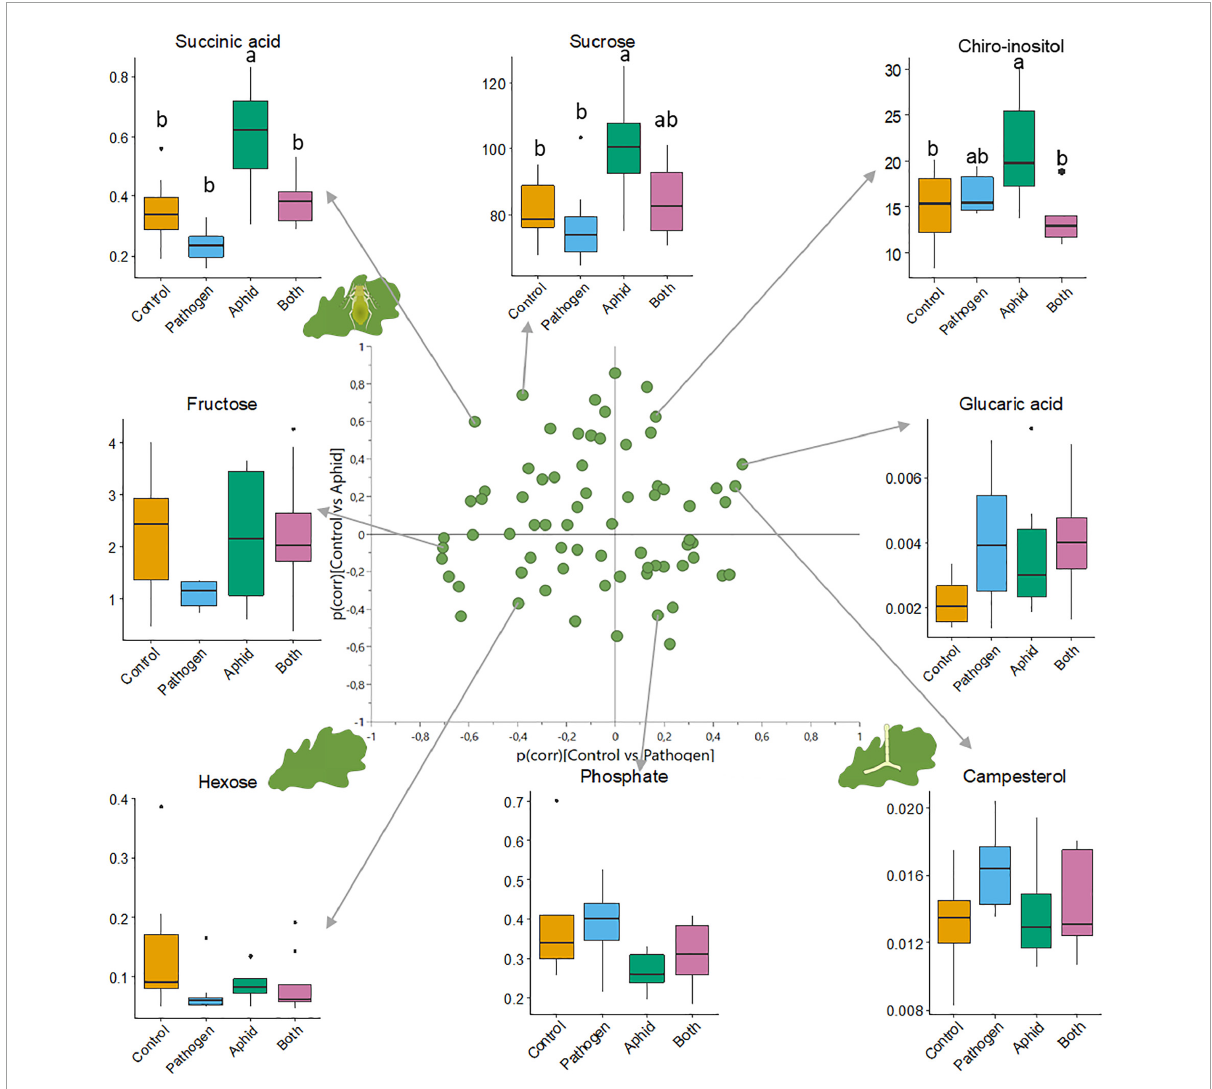
FIGURE2 SUS-plot of control vs. pathogen and control vs. aphid with representative boxplots for metabolites at the extremes of the plot. The SUS-plot shows how metabolite levels differ between healthy seedlings and mildew infected seedlings vs. healthy seedlings and aphid infested seedlings. The axes of the SUS-plot are the p (corr)-values of each of the two pair-wise OPLS-DA models used in this figure ( Supplementary Table 3 ). The box plots show the response of individual metabolites to attacker treatments, where the vertical axis of the box plots is the relative abundance of the metabolite after normalization. Significant differences between treatments are noted by a letter above the boxes where groups that do not share the same letter differ. There were eight replicates per treatment group, and each treatment is represented by a different color, with control plants as orange, powdery mildew infected plants as blue, aphid infested plants as green, and dual-infected plants as